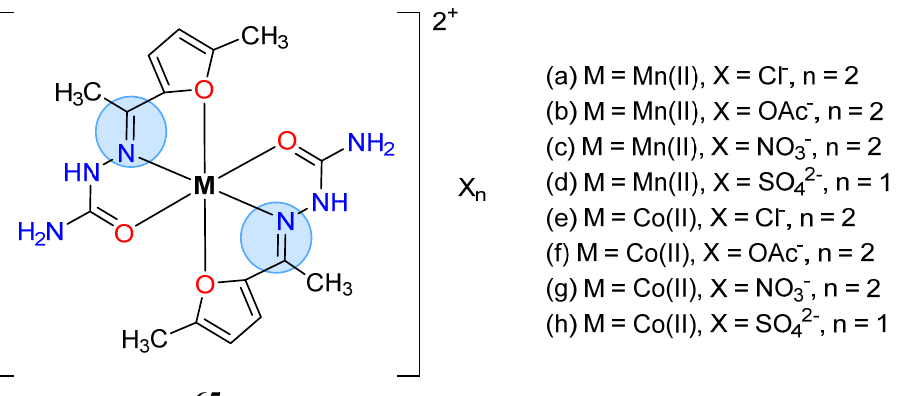
Figure 28. Mn(II) and Cu(II) complexes with a Schiff base derived from 2 ‐ bromo ‐ 4 ‐ chloro ‐ 6 ‐ [(2 ‐ hy ‐